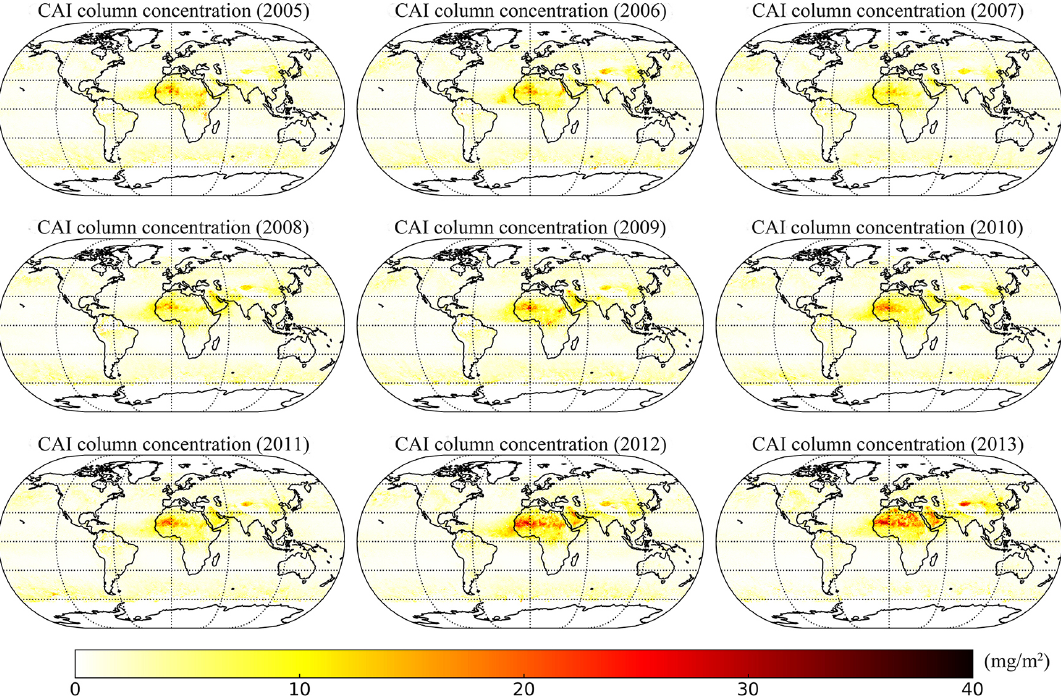
Figure 10. Yearly mean of CAI column mass concentration (mgm − 2 ) derived from POLDER-3 observations using the GRASP/Component approach for the period from March 2005 to October